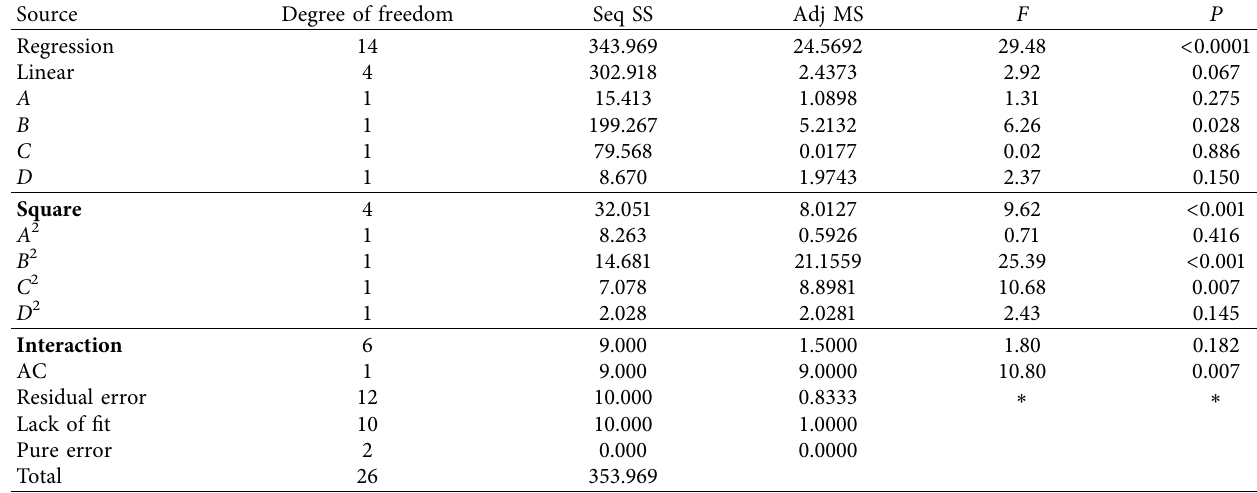
Table 2: Analysis of variance for the removal of Remazol Black B.